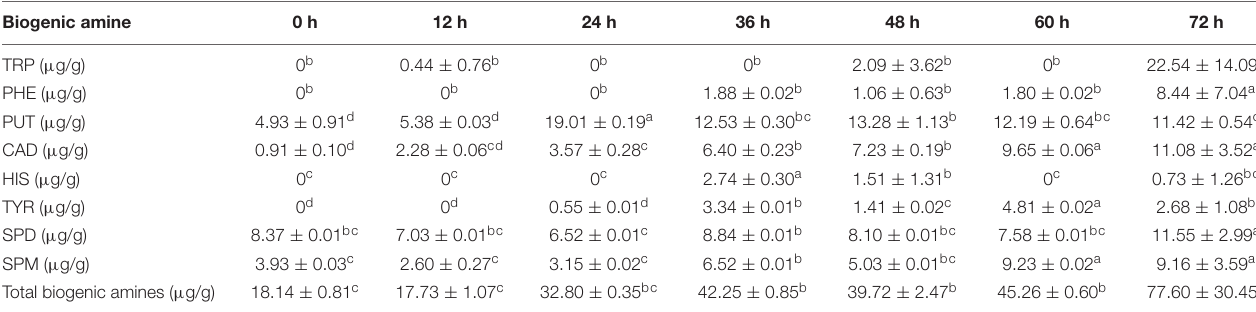
FIGURE 4 | Bacterial and fungal principle coordinate analysis (PCoA) based on the weighted Unifrac distance at the OTU level, and CCA analysis based on the genus level (top 20 genera) in the non-post fermented Shuidouchi: (A) bacterial PCoA; (B) fungal PCoA; (C) the CCA of the bacterial communities in the samples; (D) CCA of the fungal communities in the samples, where T, temperature; BA, total biogenic amines concentration; BD, 2,3-butanediol. TABLE 4 | Changes in the biogenic amine concentration in the non-post fermented